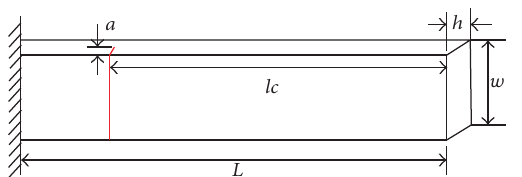
Figure 2: Schematic diagram of the equivalent cantilever beam with a crack.